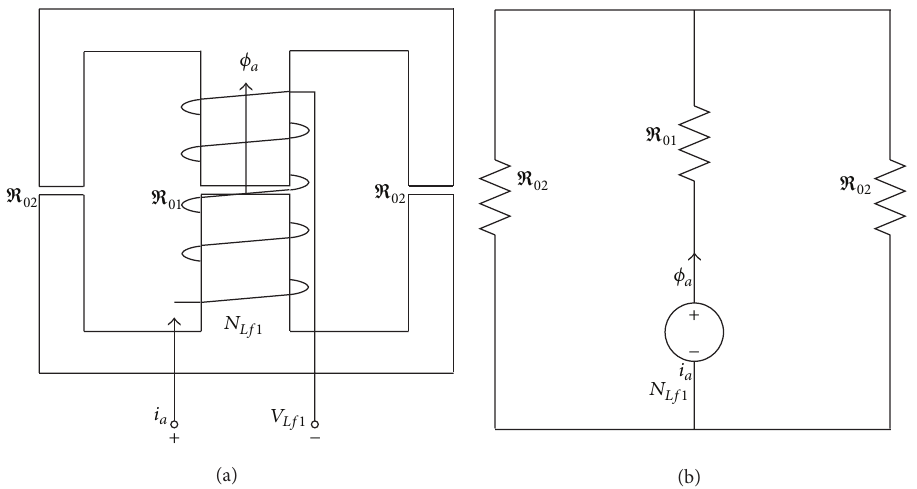
Figure 3: Three-phase discrete inductor: (a) magnetic core, (b) magnetic